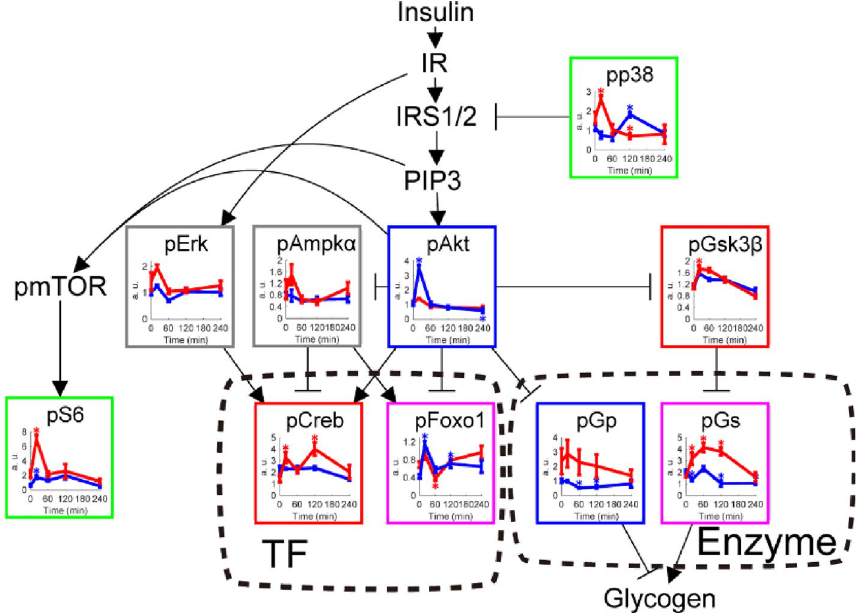
Figure 4. Identification of glucose-responsive phosphorylation of insulin signaling molecules. Time courses of the amount and phosphorylation of the indicated insulin signaling molecules in the skeletal muscle of WT mice (blue lines) and ob / ob mice (red lines) following oral glucose administration. Phosphorylated proteins are indicated by the prefix “p.” The time course graphs are presented in the context of the insulin signaling pathway from the KEGG database 18,19 . Edges reflect direct or indirect regulatory events. Not all molecules in this pathway are shown. The nodes without time course graph (insulin receptor [IR], insulin receptor substrate 1/2 [IRS1/2], phosphatidyl-inositol 3,4,5-trisphosphate [PIP3], and mammalian target of rapamycin [mTOR]) were not quantified here. The colors of the boxes around each graph indicate the change in amount or phosphorylation specific to WT (blue), specific to ob / ob (red), common to both (green), opposite between WT and ob / ob mice (pink). Proteins that did not exhibit a change in phosphorylation are outlined in gray. Proteins that showed an absolute log defined as glucose-responsive. Glucose-responsive molecules in the TF and Enzyme layers are enclosed in dashed boxes. See Data File S8 for the unabbreviated names of the insulin signaling molecules. Data are shown as the mean and SEM of five mice per genotype (see Fig. S6 for Western blot). *q value < 0.1 and absolute log 2 fold change >